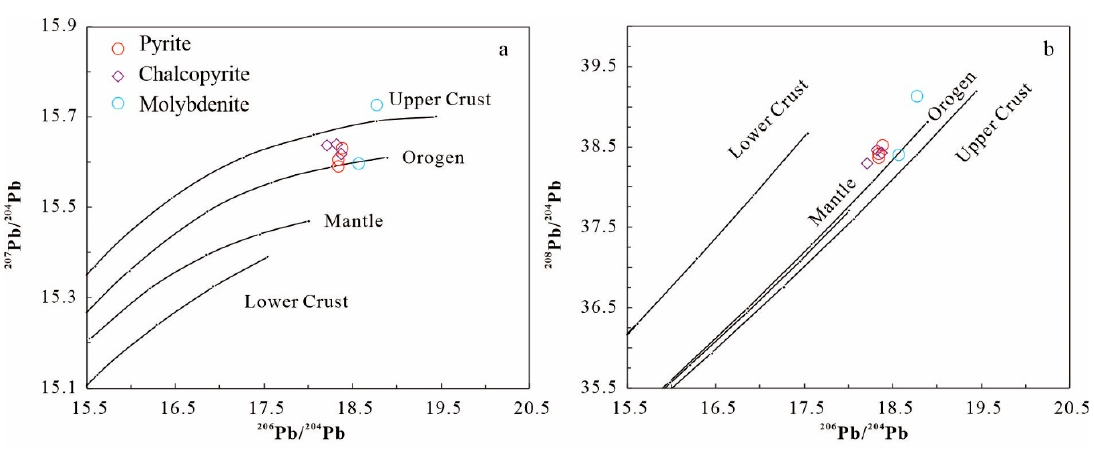
Figure 10. Histogram of sulfur isotopic compositions from the Reshui Mo deposit. Data sources: data of the Chalukou deposits in the Tianshan - Xingmeng orogenic belt are from Liu et al. [61]; data of the Qian’echong, Jinduicheng, Tangjiaping, and Nannihu deposits in the Qinling–Dabie Mo belt are from Yang et al. [74]; Li et al. [98] and Zhang et al. [44]; data of the Climax and Henderson deposits in western America are from Stein et al. [99]. ( a ) Histograms of δ 34 S values in the Reshui Mo deposit; ( b ) Comparison of the Reshui Mo deposit with other porphyry Mo deposits.